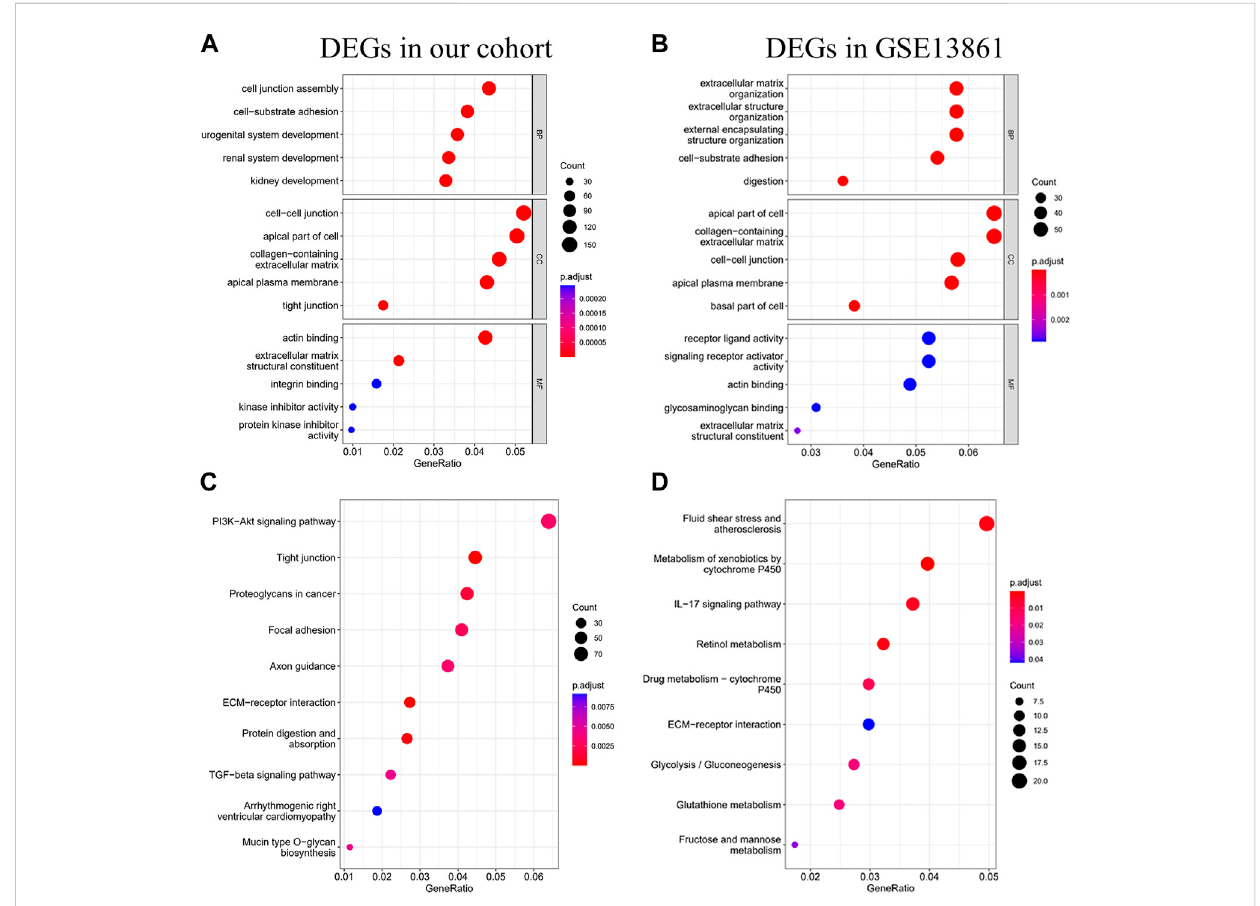
FIGURE 3 GO and KEGG analysis of DEGs. GO analysis (A) , and KEGG analysis (C) of DEGs in our cohort. GO analysis (B) , and KEGG analysis (D) of DEGs in GSE13861